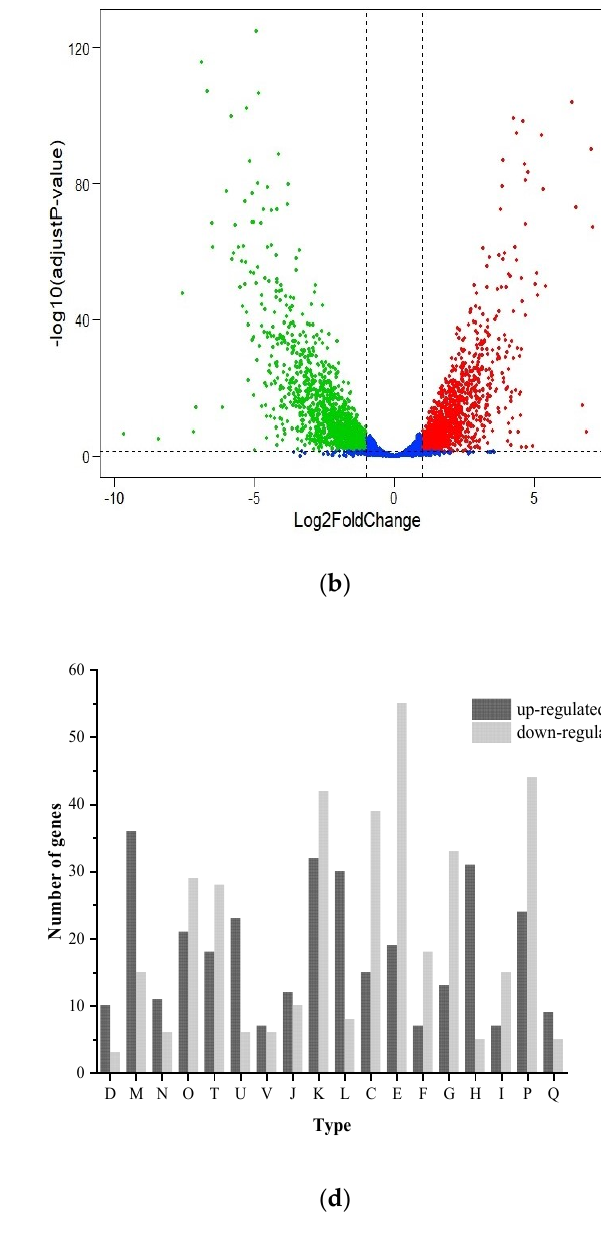
Figure 6. The volcano plots of genes and COG functional annotations between different treatment. ( a ) Volcano plots displaying differential expressed genes between 0% NaCl and 2% NaCl cultured V. brasiliensis ; ( b ) Volcano plots displaying differential expressed genes between 7% NaCl and 2% NaCl cultured V. brasiliensis . (Screening criteria for differentially expressed genes: adjust p value < 0.05, Abs (log 2 Fold Change) ≥ 1); ( c , d ) COG functional annotations of differentially expressed genes identified in 0% NaCl and 7% NaCl cultured bacteria, respectively. (Abs (log 2 Fold Change) ≥ 2). COG functional description represented by capital letters. D: Cell cycle control, cell division, chromosome partitioning; M: Cell wall/membrane/envelope biogenesis; N: Cell motility; O: Posttranslational modification, protein turnover, chaperones; T: Signal transduction mechanisms; U: Intracellular trafficking, secretion, and vesicular transport; V: Defense mechanisms; J: Translation, ribosomal structure and biogenesis; K: Transcription; L: Replication, recombination and repair; C: Energy production and conversion; E: Amino acid transport and metabolism; F: Nucleotide transport and metabolism; G: Carbohydrate transport and metabolism; H: Coenzyme transport and metabolism; I: Lipid transport and metabolism; P: Inorganic ion transport and metabolism; Q: Secondary metabolites biosynthesis, transport and catabolism; S: Function unknown (not shown in the